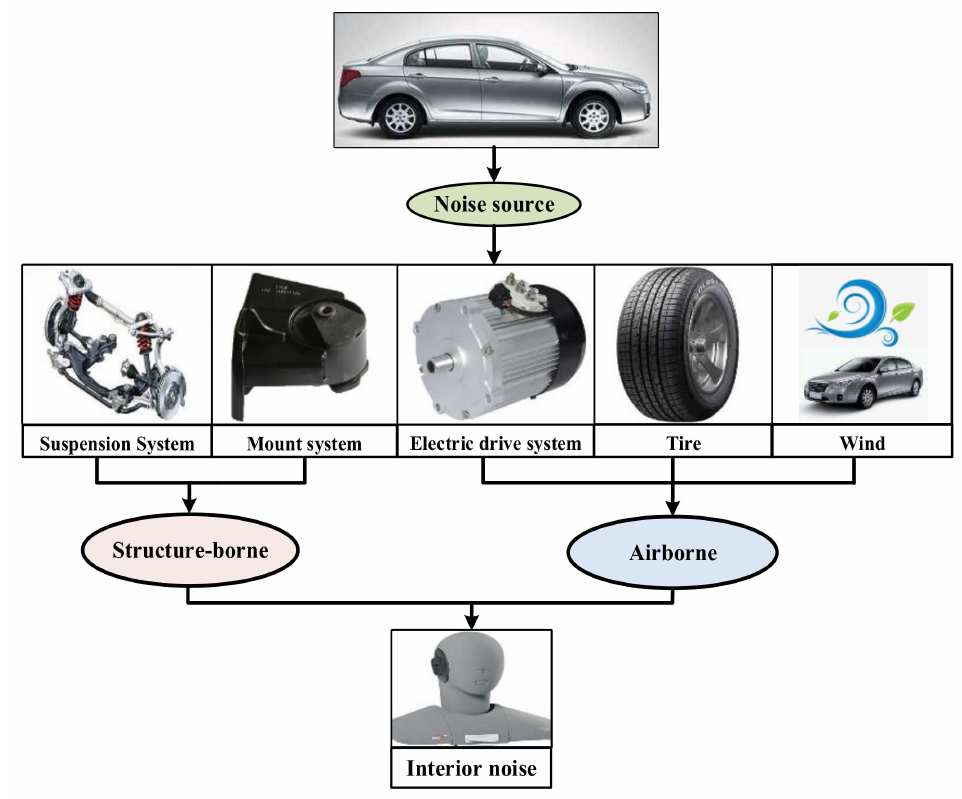
Figure 1. Schematic of the pure electric vehicle (PEV) noise transfer